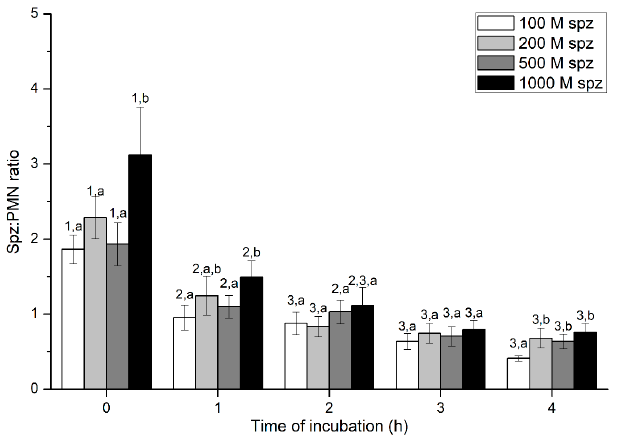
Figure 6. Number of spermatozoa bound to PMN (sperm:PMN ratio) after incubation with four different sperm concentrations (100 × 10 6 , 250 × 10 6 , 500 × 10 6 , and 1,000 × 10 6 spermatozoa/mL) for 4 h (Experiment 3). Different superscripts ( a, b ) mean significant ( p < 0.05) differences between treatments within a given time point, and different numbers ( 1, 2 ) mean significant ( p < 0.05) differences between incubation times within a given treatment. Data are shown as mean ± SEM for seven experiments. PMN concentration: 100 × 10 6 PMN/mL.